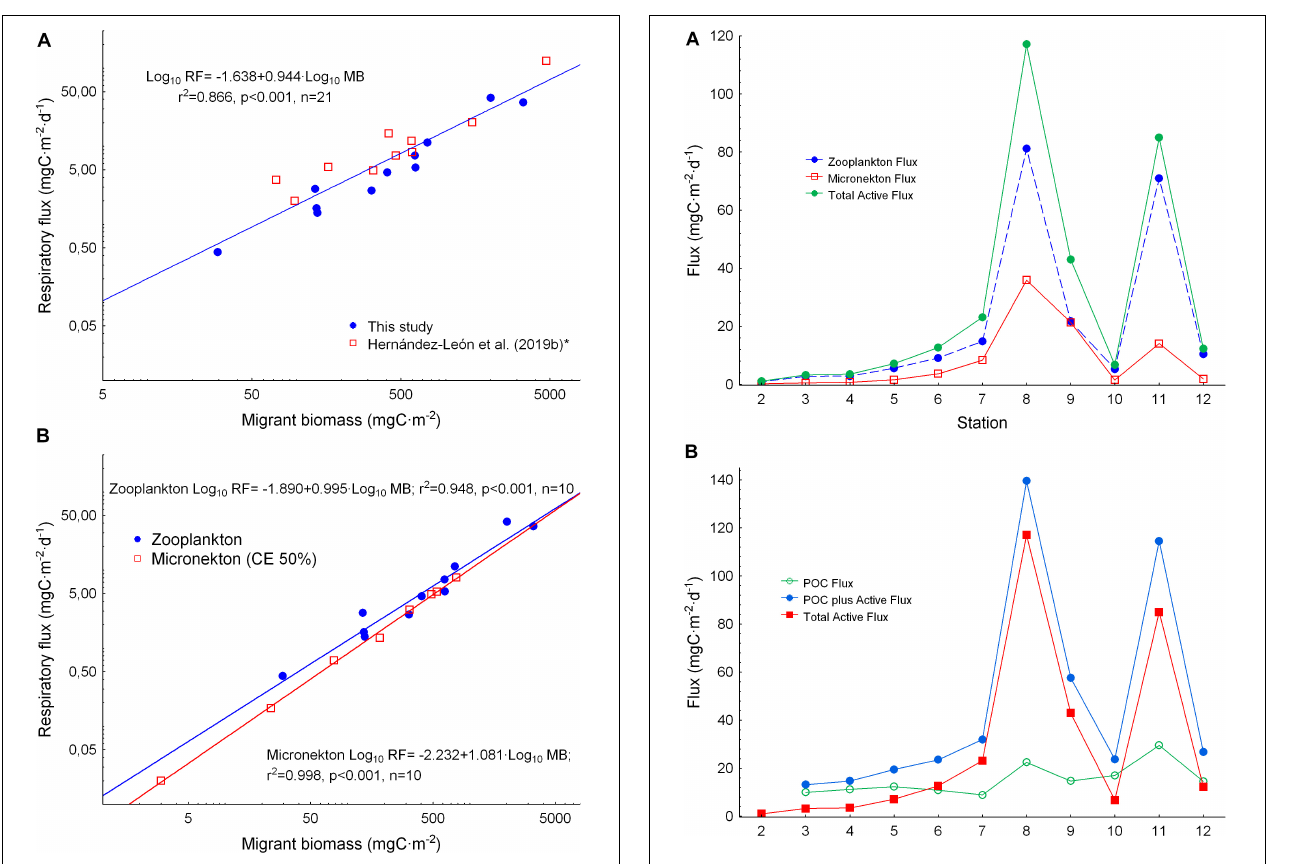
FIGURE 8 | (A) Relationship between zooplankton migrant biomass and respiratory flux for this study (filled dots) and results by Hernández-León et al. (2019b). The data from the latter authors were converted to the new Dw/Prot ratio of Hernández-León et al. (2019a). See text for details. (B) Comparison between migrant biomass and respiratory fluxes by zooplankton and micronekton in the present study using a 50% of capture efficiency for the Mesopelagos trawl.